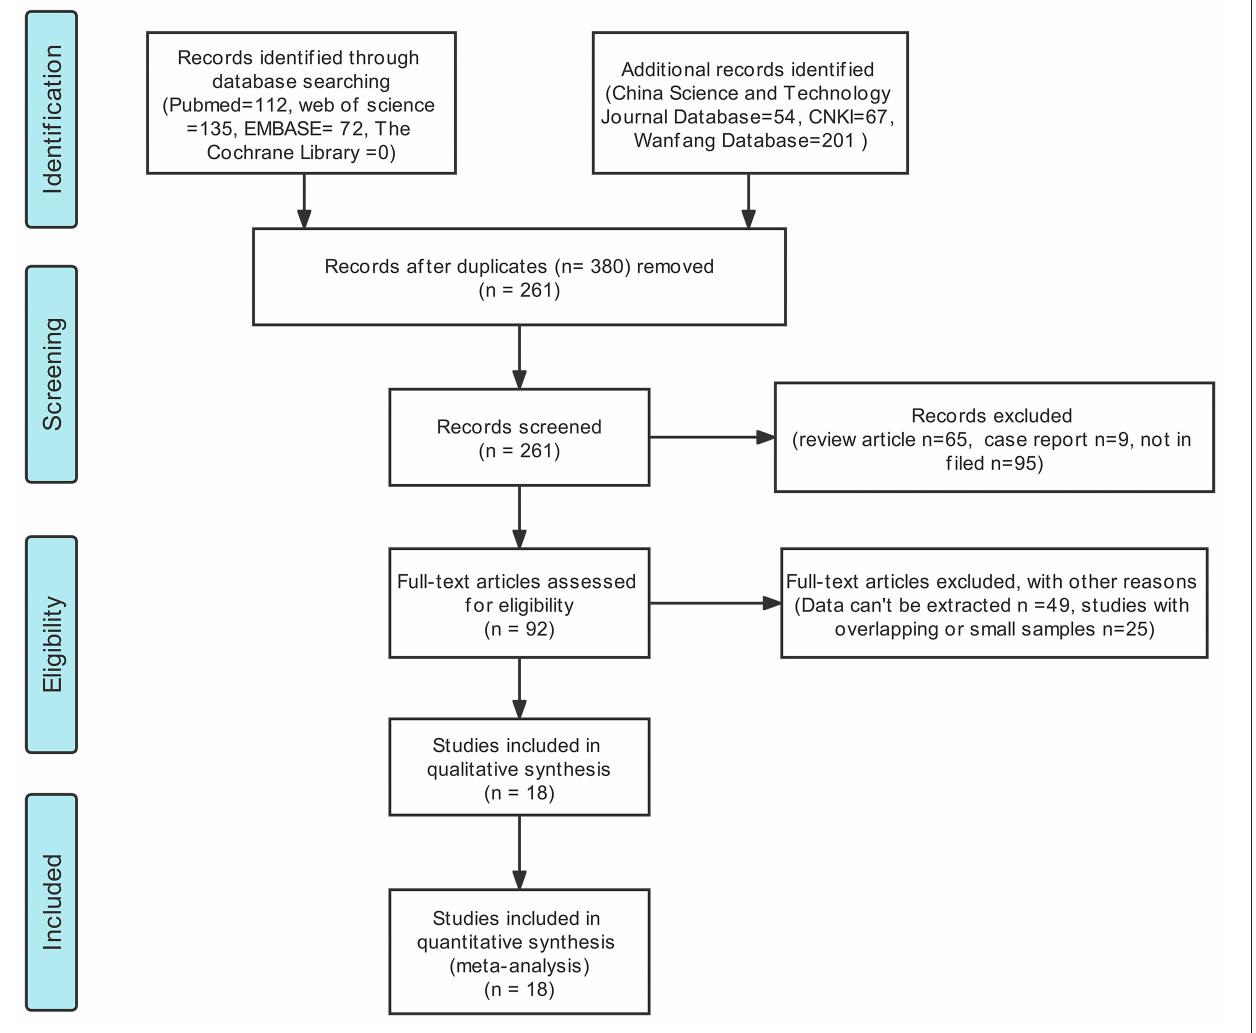
FIGURE 1 | A Flowchart representing the literature selection